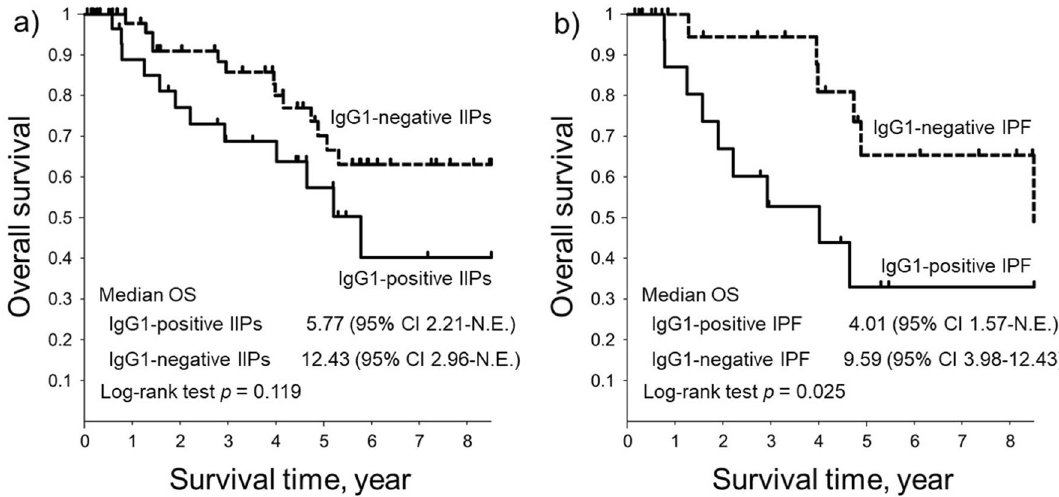
Figure 2. Survival curves of patients with either IIPs or IPF with or without IgG1-positive cell infiltration. ( a ) The Kaplan–Meier curve of the overall survival of patients with idiopathic interstitial pneumonias with or without IgG1-positive cell infiltration in the lungs (IgG1-positive or negative IIPs). (Solid line: IgG1- positive IIPs, Broken line: IgG1-negative IIPs). ( b ) The Kaplan–Meier curve of the overall survival of patients with idiopathic pulmonary fibrosis with or without IgG1-positive cell infiltration in the lungs (IgG1-positive or negative IPF). (Solid line: IgG1-positive IPF, Broken line: IgG1-negative IPF). CI confidence interval, Ig